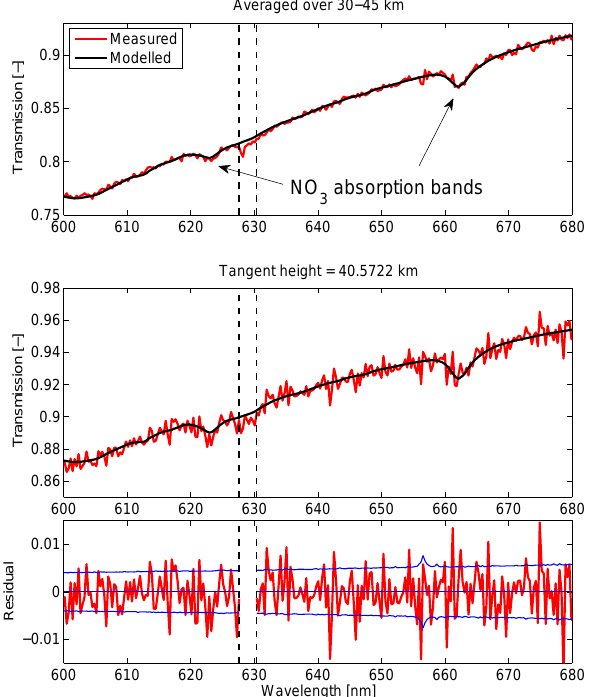
Fig. 1. An example of the GOMOS spectral fit. Uppermost panel shows GOMOS mean spectral fit calculated from the tangent heights between 30 and 45km. Middle panel shows spectral fit at 40km, and the lowermost panel is the residual at 40km. The ex- ample is the same as in Fig. 4. NO 3 absorption features are clearly visible. Note that in the GOMOS Level 2 processing the spectral